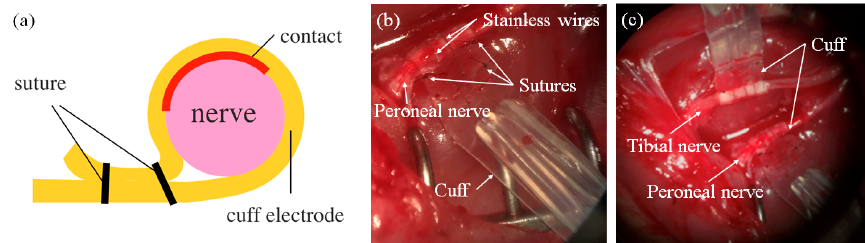
Figure 6. Cuff electrode as a neurostimulator-nerve interface: ( a ) A cross-sectional view of the cuff electrode fixed on a peripheral nerve; ( b ) The actual cuff electrode fixed on a rat peroneal nerve; ( c ) The two cuff electrodes fixed on a rat peroneal and tibial nerve respectively.